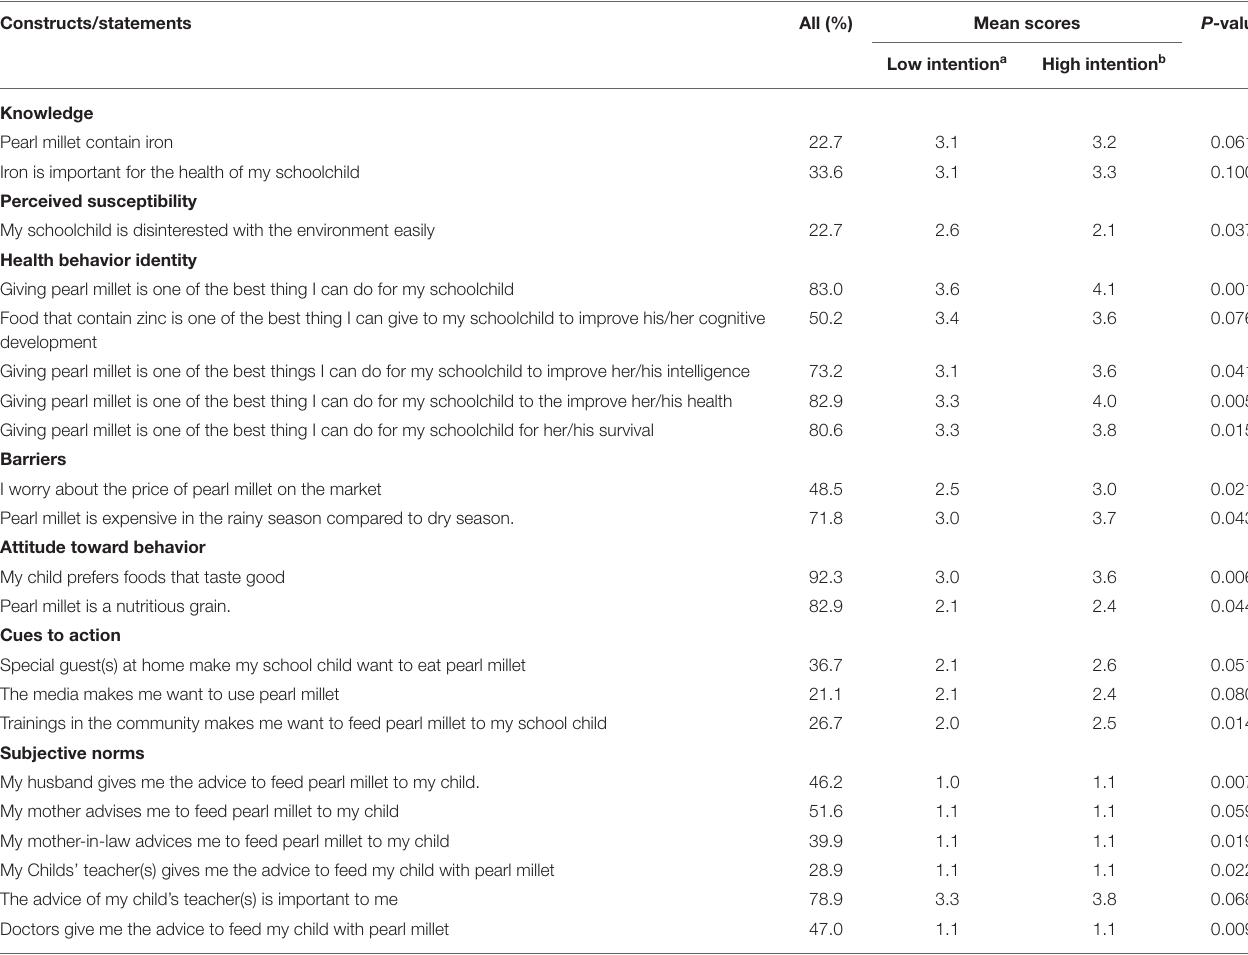
TABLE 4 | Comparison between high and low intenders of pearl millet